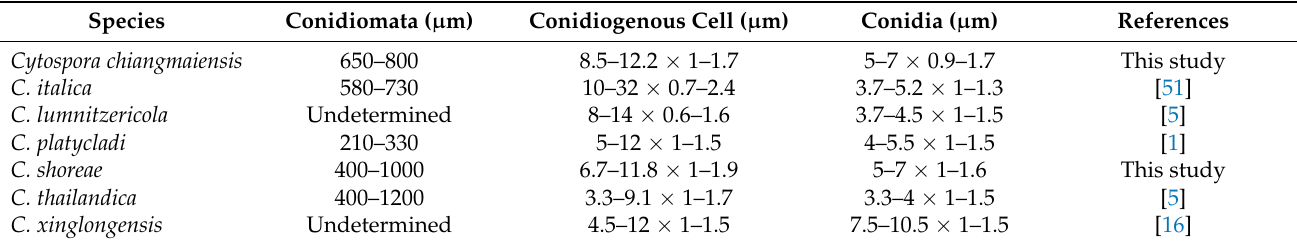
Table 4. Synopsis of asexual morph of Cytospora species discussed in this